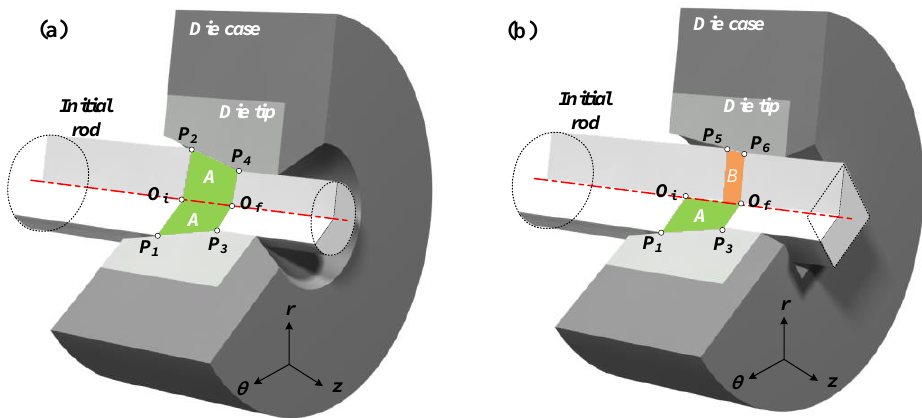
Figure 2. Schematic of the deformation zone in the drawing process: ( a ) rod-drawing process and ( b ) shape-drawing process.